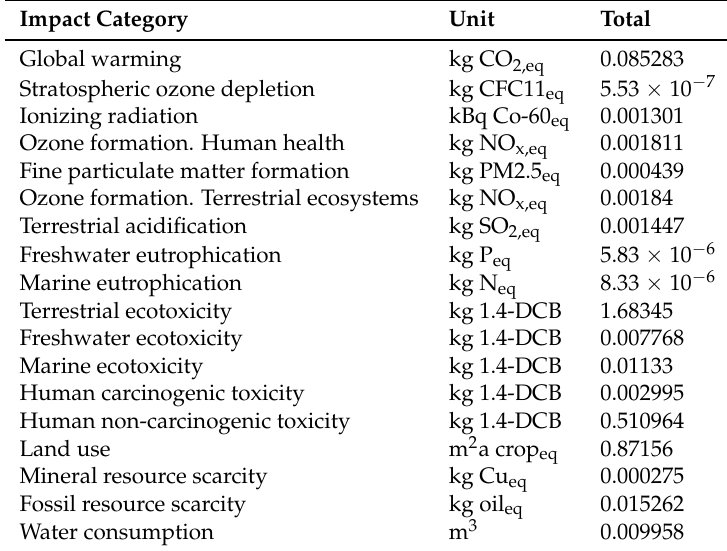
Table 4. Summary of the mass stream of the ORC